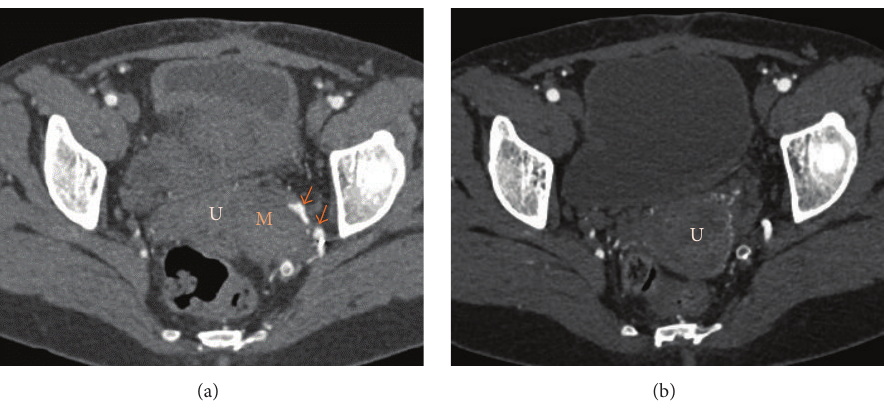
Figure 4: Follow-up pelvic CT scan. (a) CT scan 3 weeks after embolization: presence of some microfistulae (red arrows) and complete obscuration of the venous pouch without regression of mass size. (b) CT scan 1 year after embolization shows complete regression of the mass without any suspicious residual tissue (U = uterus, M =